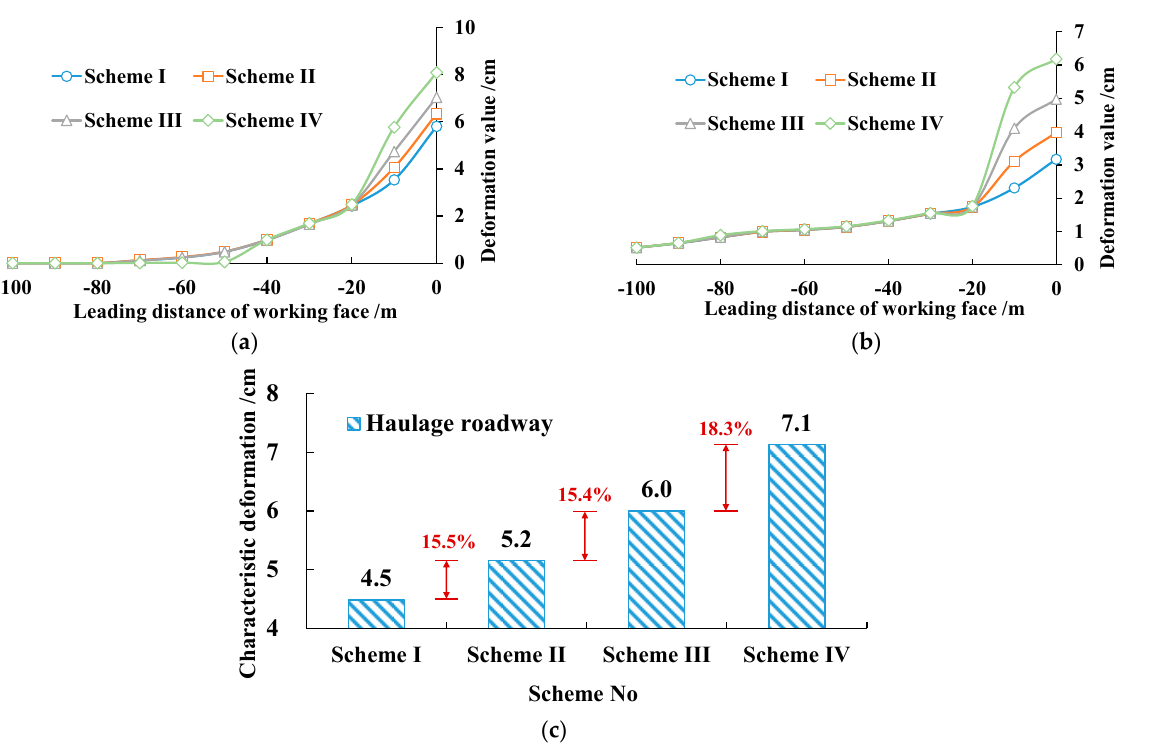
Figure 6. Comparison of the surrounding rock deformation of the haulage roadway in each scheme. ( a ) Roof and floor convergence deformation. ( b ) Convergence deformation of the two sides. ( c ) Comparison of the quantitative evaluation index of each scheme.